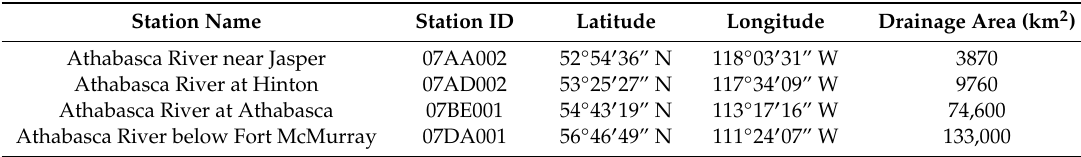
Table 1. Summary of the information for the four gauging stations used to gather hydrometric data along the Athabasca River for model calibration and